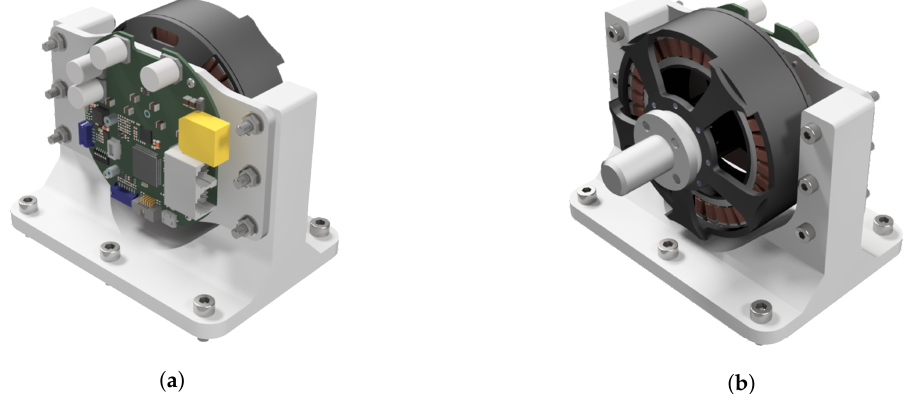
Figure A5. Rendered 3D models of the entire motor module hardware, including ( a ) the U10 PLUS KV80 motor and ( b ) the motor controller PCB developed at SDU. The motor module is mounted on the 3D print model test